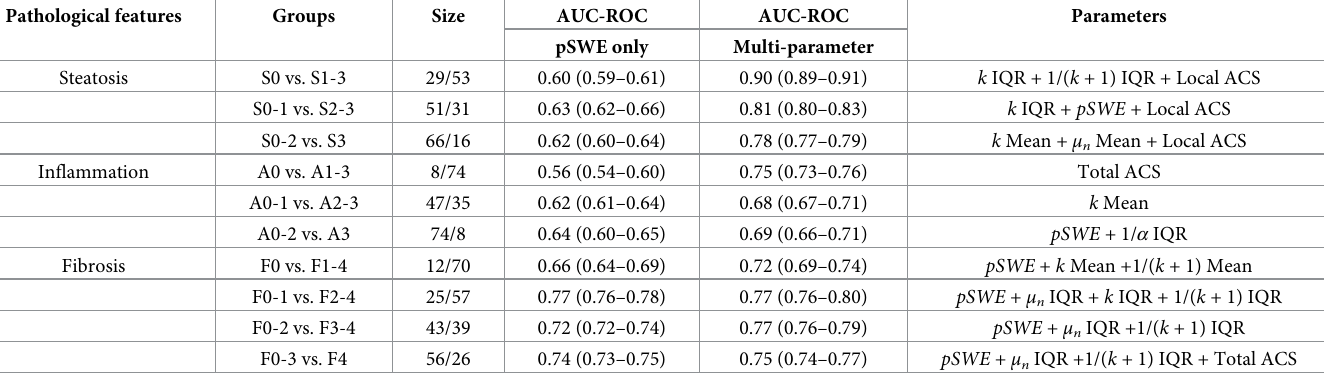
ACS = attenuation coefficient slope. AUC-ROC = area under the receiver operating characteristic curve. Numbers in parentheses are 95% confidence intervals. size = N/ M , where N = number of cases (out of 82 patients) such that pathological feature � x (= 0, 1, 2, or 3) and M = 82 – N ; pSWE = point shear wave elasticity; μ n = mean intensity normalized by its maximal value; 1/ α = reciprocal of the scatterer clustering parameter; k = coherent-to-diffuse signal ratio; 1/( k + 1) = diffuse-to-total signal power ratio; IQR = inter-quartile